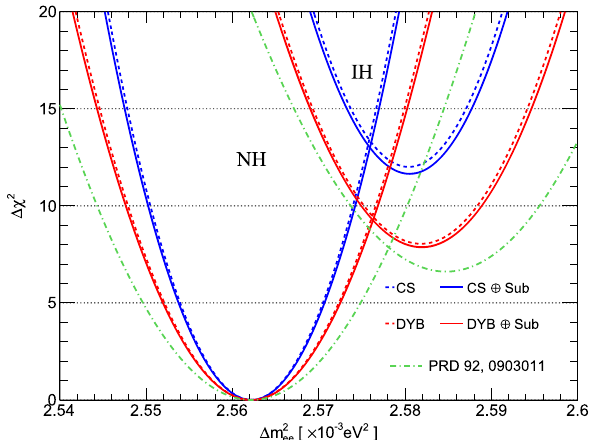
Fig. 5 Sensitivity of MH resolution using shape uncertainty from fine structure (solid lines) and without (dashed lines). NH is assumed to be the true MH. The curves on the left side correspond to the fitting of NH and curves on right side correspond to the assumption of IH (false MH). The blue curves represent the conventional assumption of 1% shape uncertainties (named as “CS” in the legend) for each bin; The red curves correspond to intrinsic uncertainties from the Daya Bay measurement (named as “DYB” in the legend). The green curves are the results based on shape uncertainties reported in Ref.